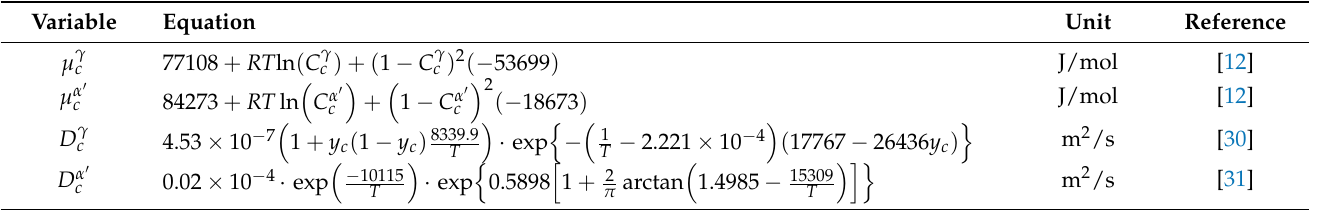
Table 1. Chemical potential and diffusivity of carbon in austenite and martensite phases.